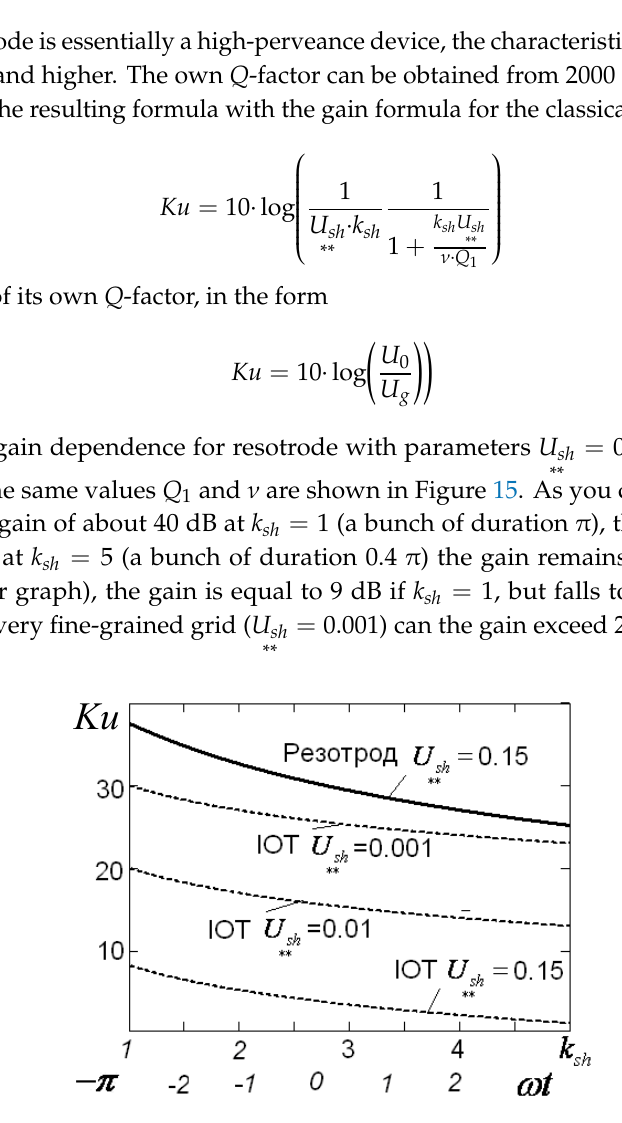
Figure 15. Dependences of the gain on the cutoff factor for resotrodes and IOTs .